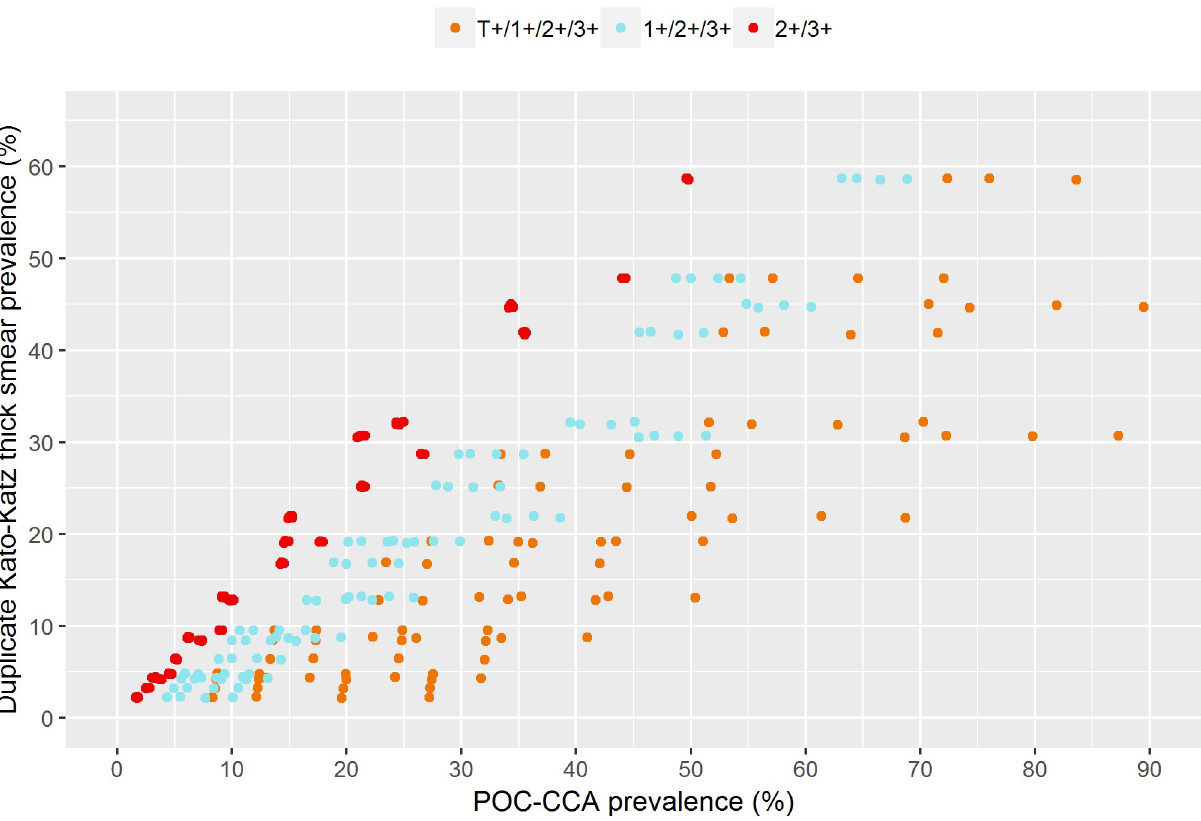
Fig 7. Scatter plot of all results for duplicate slide Kato-Katz from Fig 5.